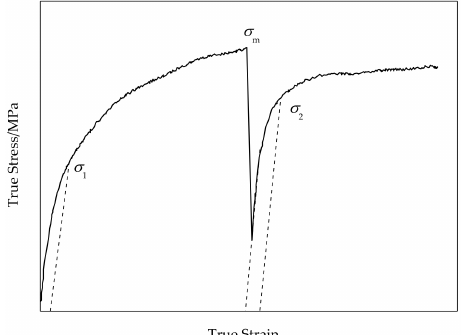
Figure 2. Schematic diagram of determining static recrystallization fraction by 2% offset